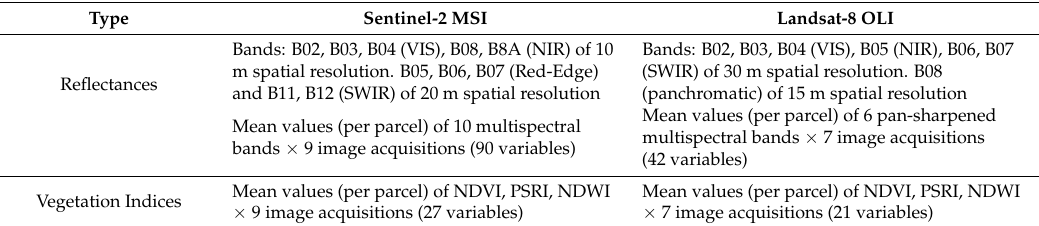
Table 1. Landsat-8 OLI and Sentinel-2 MSI variable spaces of multispectral band reflectances and vegetation indices; the pixels values are averaged for each